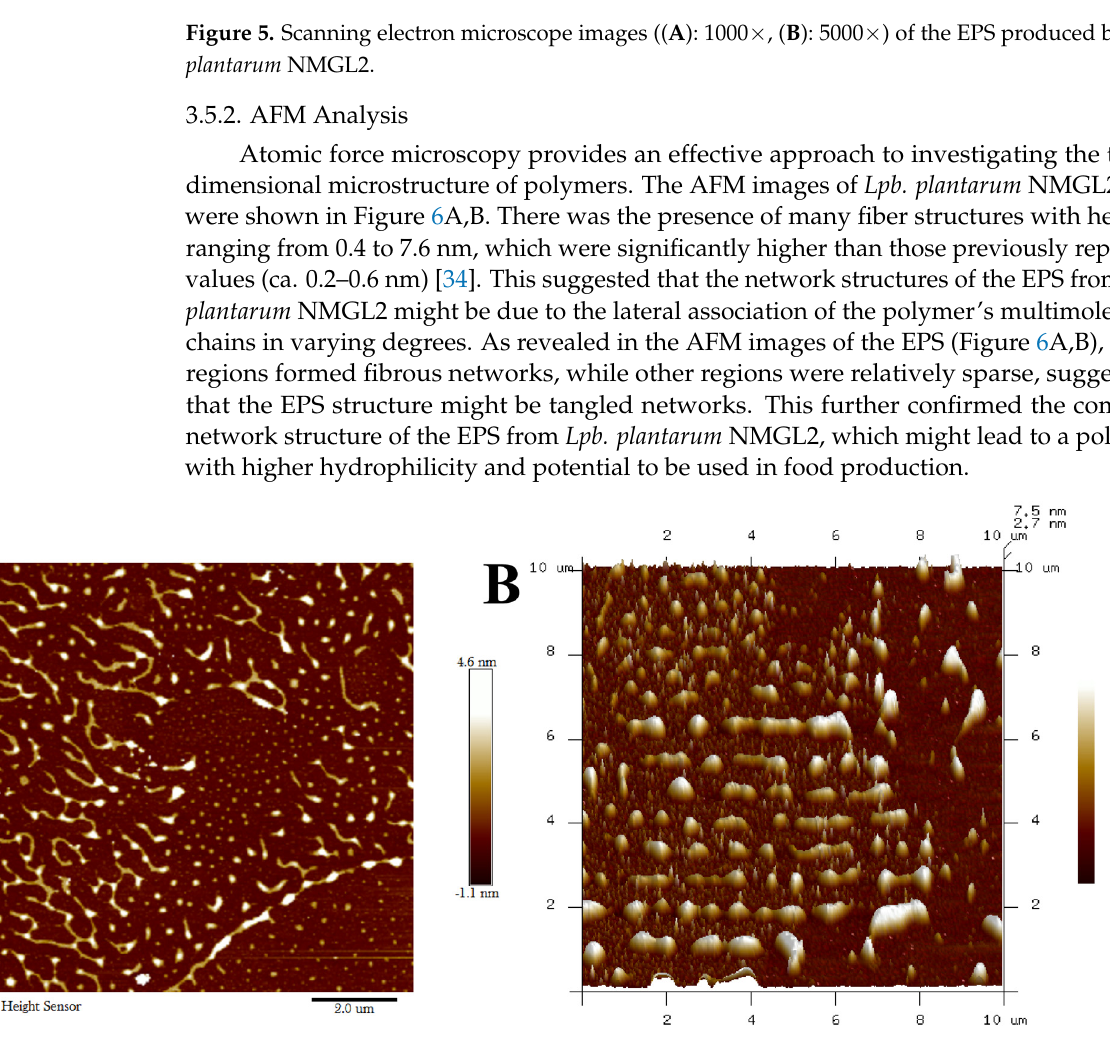
Figure 5. Scanning electron microscope images (( A ): 1000×, ( B ): 5000×) of the EPS produced by Lpb. plantarum NMGL2.